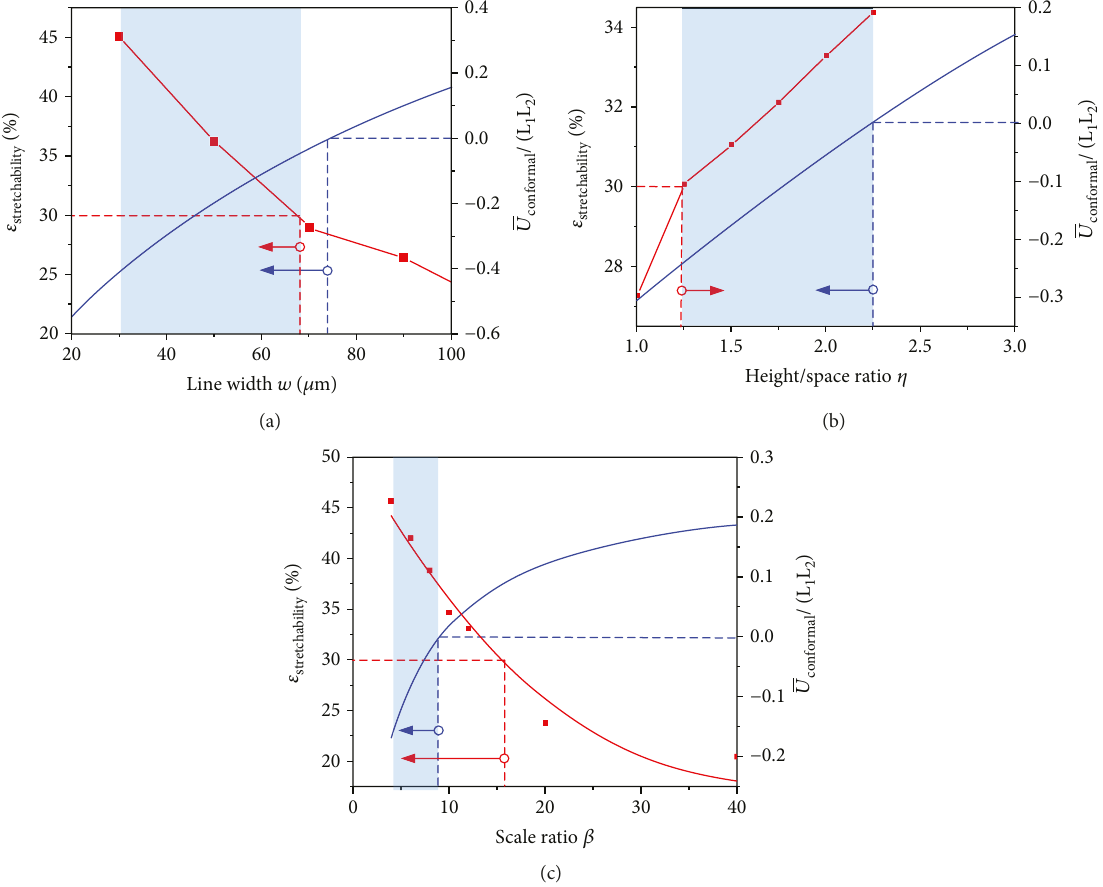
Figure 5: The feasible range of geometric parameters for the stretchability and conformability of the network-shaped electrode: the e ff ects of (a) line width w , (b) height-space ratio η , and (c) scale ratio β